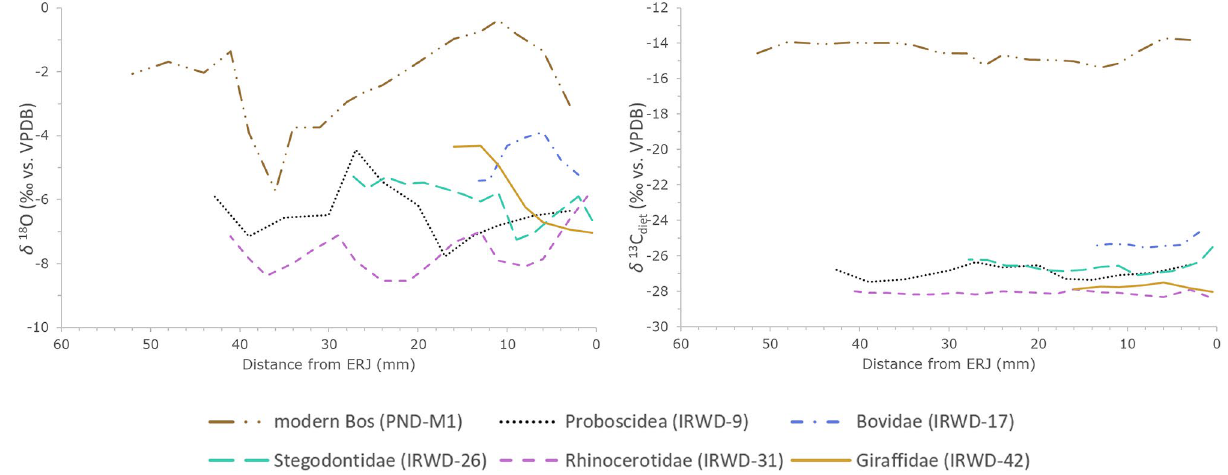
Figure 3. Comparison of the intra-individual serial sampling of a Miocene rhino from the Irrawaddy Fm. with a modern bovid from the Central Basin in Myanmar. Distance from ERJ (enamel root junction) is plotted in reverse order to correctly represent the enamel mineralization from oldest (left) to youngest (right).